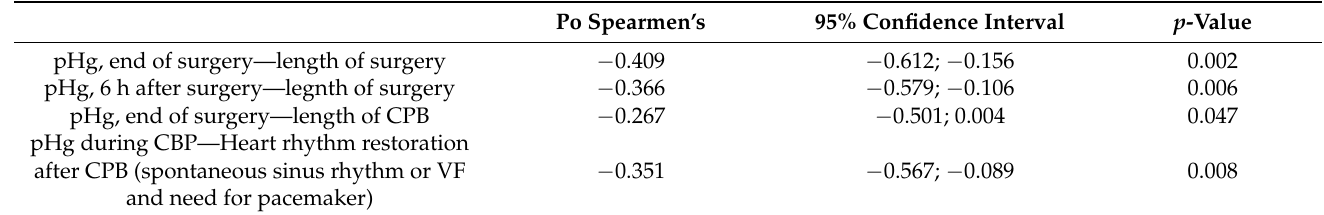
Table 3. Correlation between the intragastric pH level and CPB and surgery duration and type of postperfusion rhythm